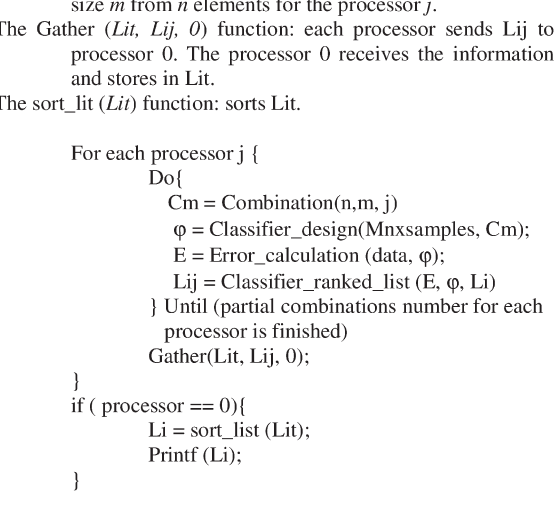
Figure 3 - Pseudo-code of GCLASS parallel version.